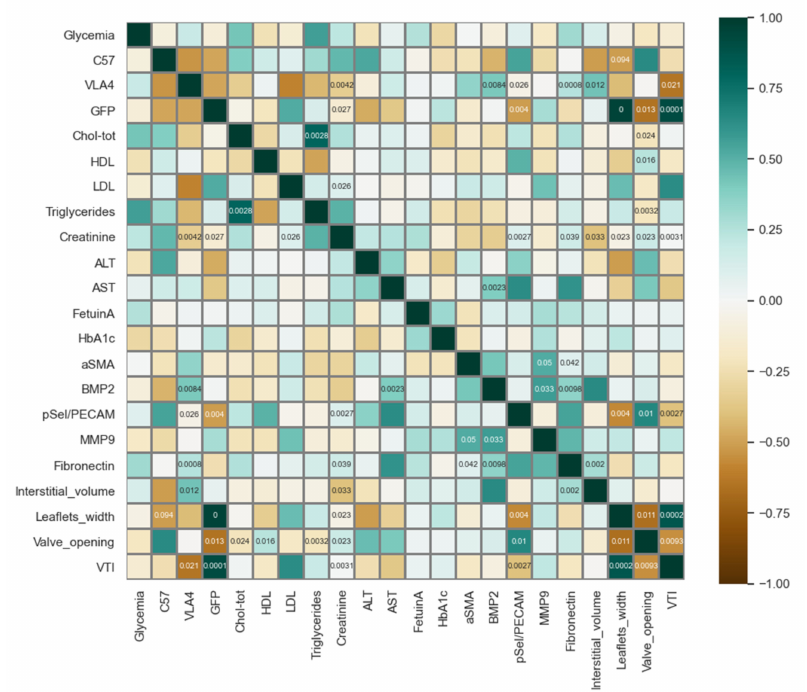
Figure 5. Correlations between plasma, echocardiographic and immunochemistry parameters. The colour scale codes for the Pearson coefficient value (dark green—perfect positive correlation, white— no correlation, and dark brown—perfect negative correlation). Significant correlations ( p < 0.05) are indicated by the p -value noted inside the respective box. C57, VLA4 and GFP are synthetic parameters indicating the received treatment (1 if yes, 0 if